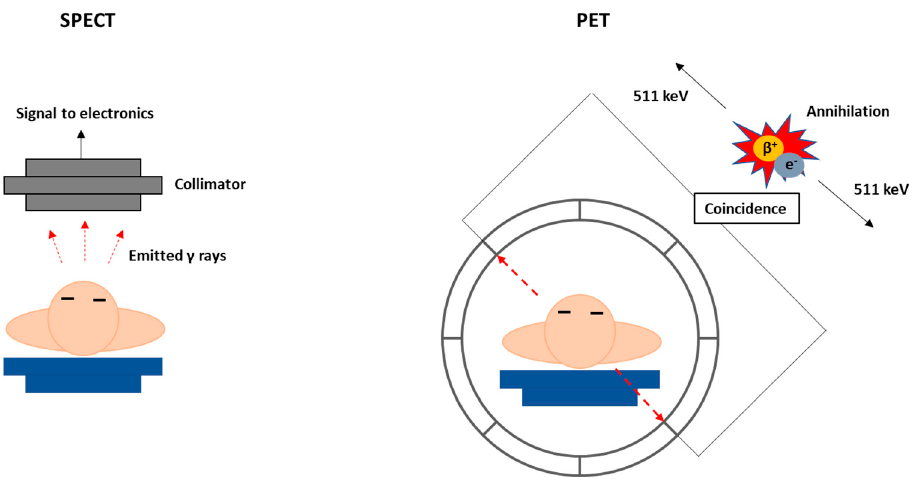
Figure 3. Schematic diagrams of SPECT ( left ) and PET ( right ) imaging. Radionuclides useful for imaging emit either γ -photons or positrons and their optimal half-life is generally going from some minutes to few hours, as can be seen in Table 1. SPECT imaging involves the detection of γ -photons in a gamma camera placed outside the patient, which are emitted directly by the radionuclide with an energy typically in the range 100–250 keV. PET imaging is based on the detection of back-to-back 511 keV annihilation photons that result from the interaction of the positrons emitted by the radionuclide with electrons from the surrounding medium (Figure 3)